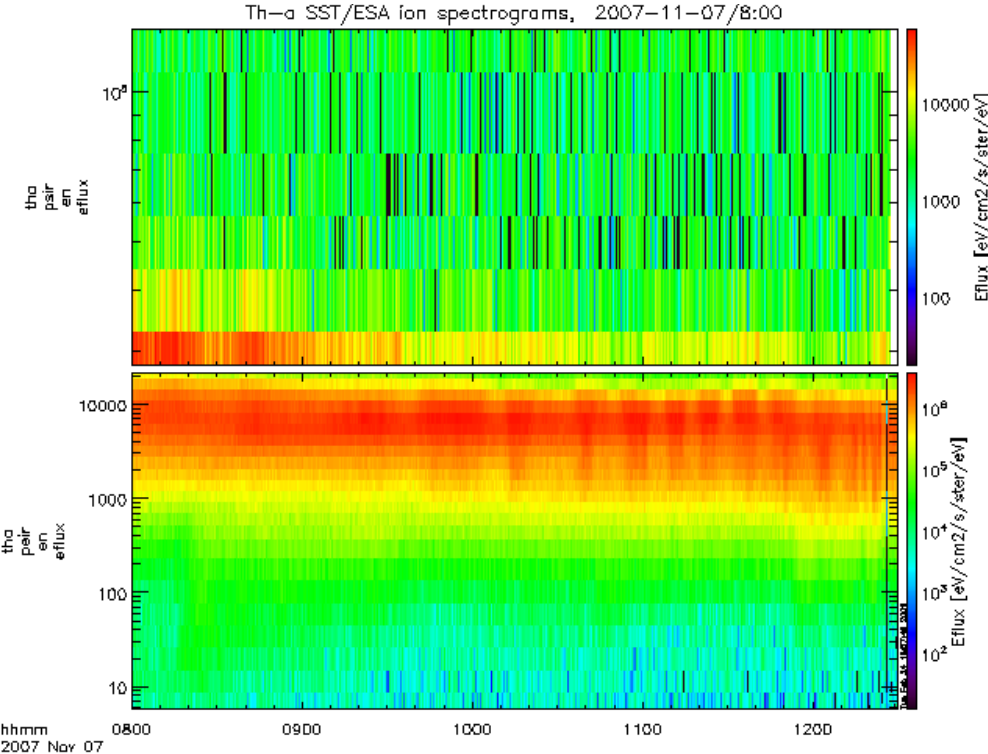
Fig. 5. Energy flux spectrograms for ions in the range of energies from 2eV to 25keV (ESA) and from 25keV to 150keV (SST) on 7 November 2007 for